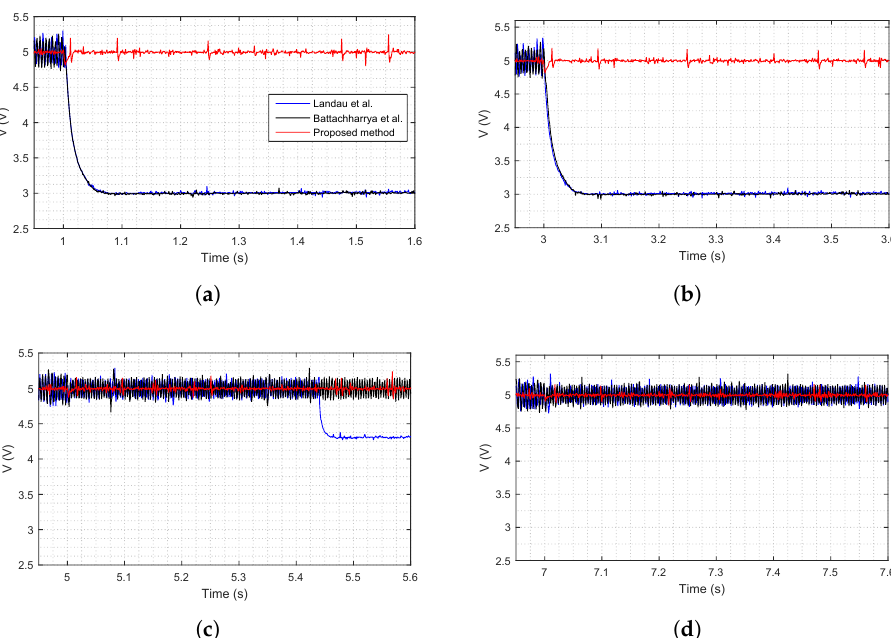
Figure 17. Zoom in experimental results of the output voltage when the system subject to a load variation. ( a ) R ref = 2.5 Ω ; ( b ) R ref = 3.0 Ω ; ( c ) R ref = 3.5 Ω ; ( d ) R ref = 4.0 Ω .